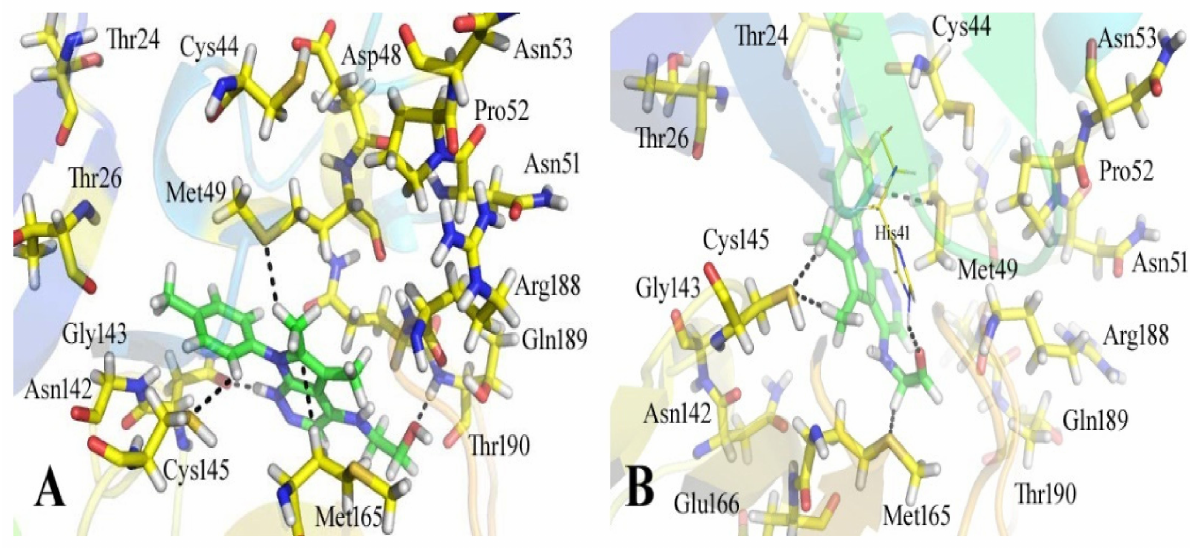
Figure 3. The binding style of the ZINC44928678 ZINC database hit at the M pro protein’s active site ( A ) before and ( B ) after